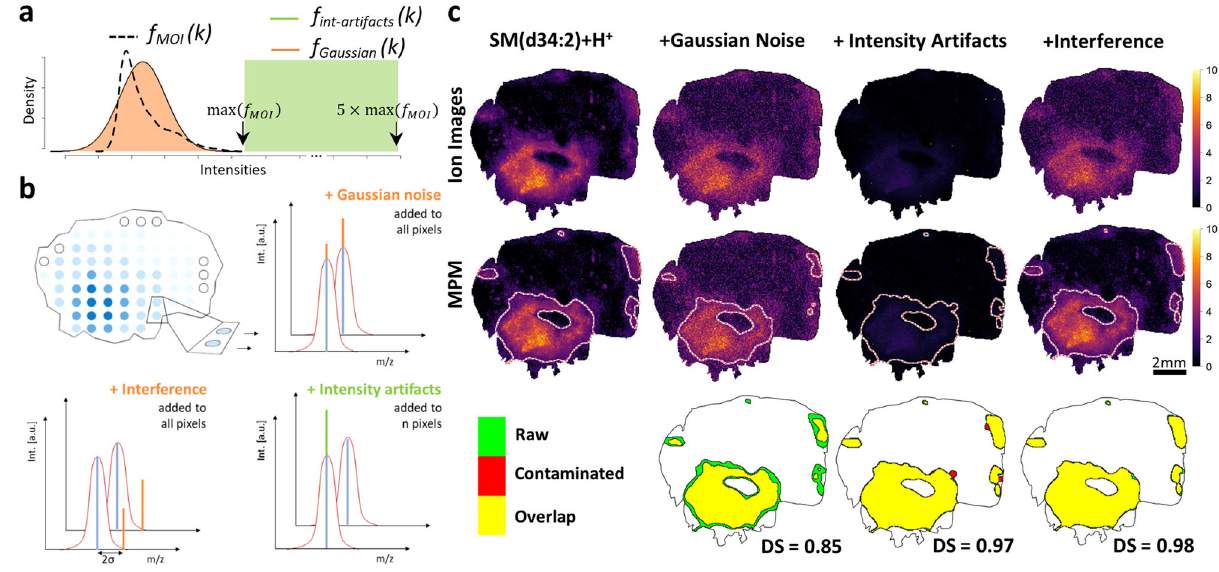
Fig. 4 | Molecular probabilistic maps (MPMs) are robust against various forms of arti fi cially added noise. a Schematic representation of ion intensity distribu- tions of a typical metabolite-of-interest (MOI) ( f MOI (k) ; dashed black curve) and of the corresponding Gaussian distribution ( f Gaussian (k); orange) from which arti fi cial Gaussian noise and interference noise ( b ) were sampled. Mean and standard deviation of f Gaussian (k) are equal to those of f MOI (k). f int-artifacts (k) is a uniform rectangular distribution whose range exceeds the range of f MOI (k) (see dotted x - axis). b Gaussiannoise is sampled from f Gaussian (k) and is added forall pixelsto the rawsignalofMOI m/z presentineachpixel.Interferencenoiseisalsosampledfrom f Gaussian (k) but is added for all pixels arbitrarily at MOI m/z + 2 σ G where σ G is the standarddeviationoftheGaussian-weightingenvelop.Thelatterisafunctionofthe mass resolving power at MOI m/z . Intensity artifact noise is sampled from f int-